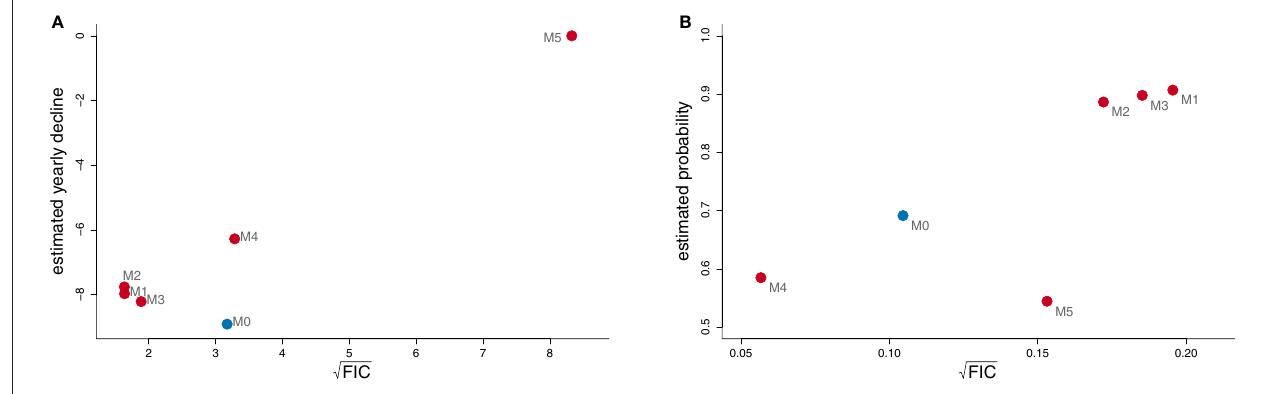
FIGURE 2 | (A) Estimates of the yearly decline in fat weight, for the Antarctic minke whale population (vertical axis), along with root-FIC scores (horizontal axis), for the wide model M 0 , marked in blue, and five additional candidate models M 1 , ... , M 5 . The scale is in kilograms of fat. (B) Root-FIC scores and estimates of the probability of observing a whale with more than 1.5 tons of fat for the wide model (marked in blue) and the five candidate models.